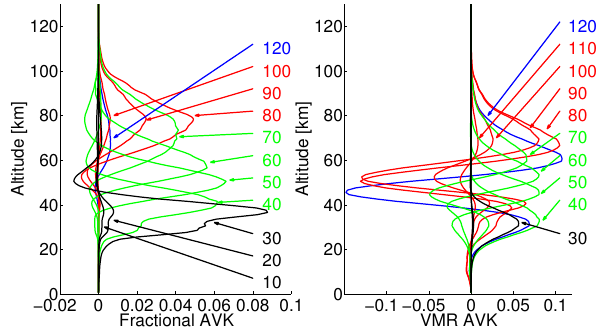
Fig. 5. Selected AVK functions for the measurement of 29 Octo- ber 2009, 06:52h, for several altitudes. Different colors represent vertical ranges with different measurement characteristics. The tar- get altitudes in km of the respective kernels are imprinted with ar- rows. The 120km kernel (blue) was multiplied by 50 to make it visible in the given scale. Left panel: fractional AVKs. The 110km AVK has been omitted since it is to small. Right panel: vmr AVKs. The 10 and 20km AVKs have been omitted for the same reason.